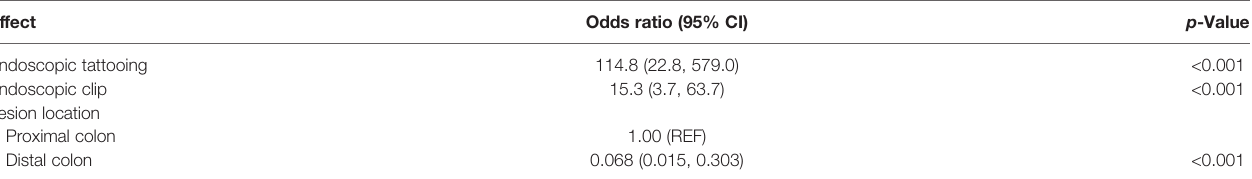
TABLE 3 | Logistic regression for successful localization of colon cancer.